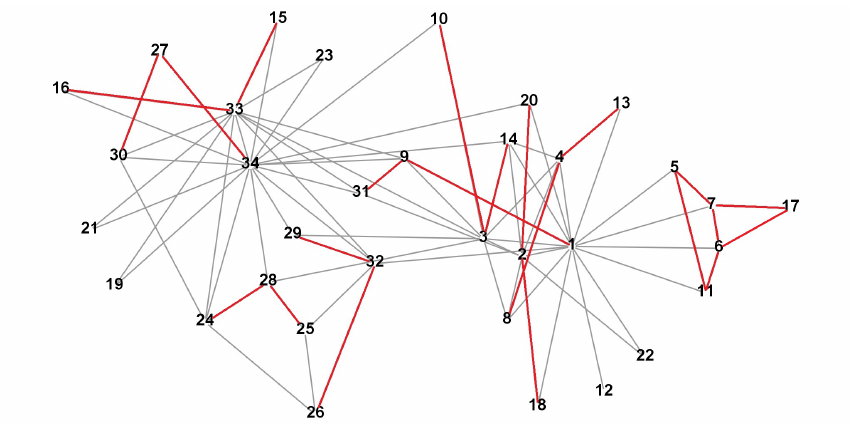
Figure 15. Packing by triplets for Zachary’s karate club